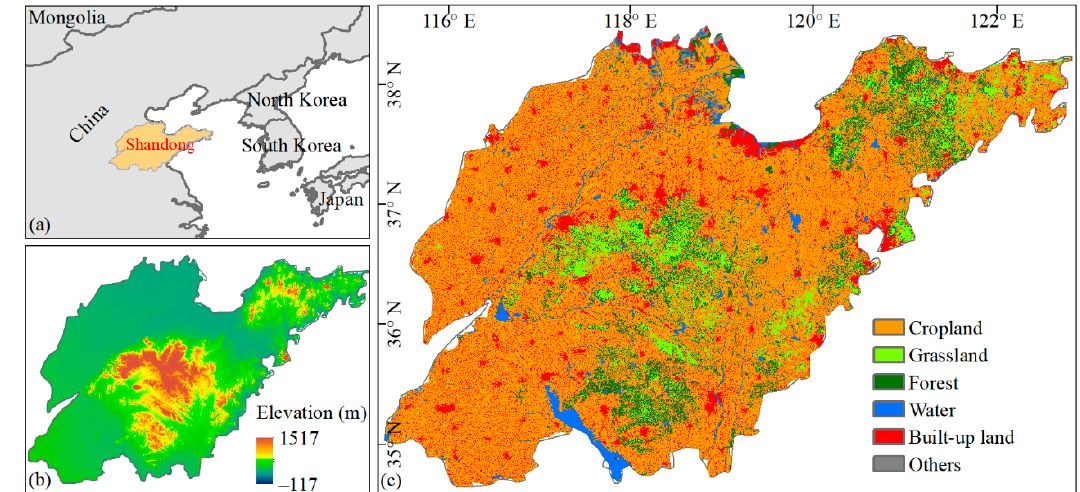
Figure 1. The location ( a ) and the elevation ( b ) of Shandong province, and the land use map in Shandong province in 2020 ( c ).